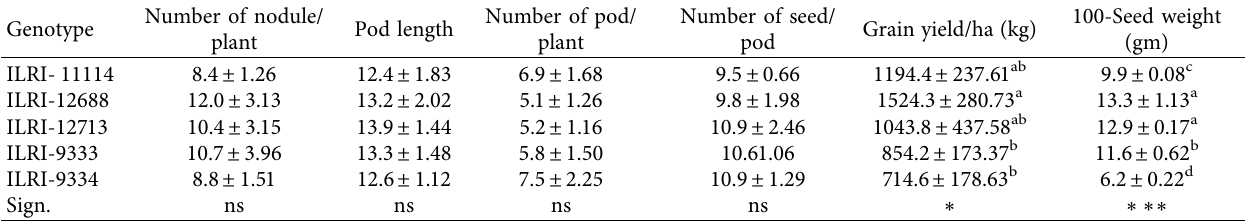
Table 6: Seed yield and yield components of cowpea genotypes (mean ±